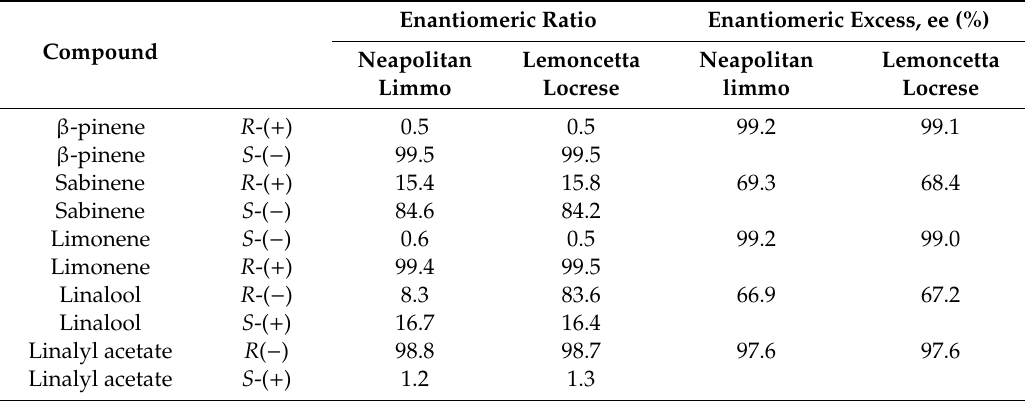
Table 3. Enantiomeric distribution of chiral compounds in Neapolitan limmo and lemoncetta Locrese essential oil.